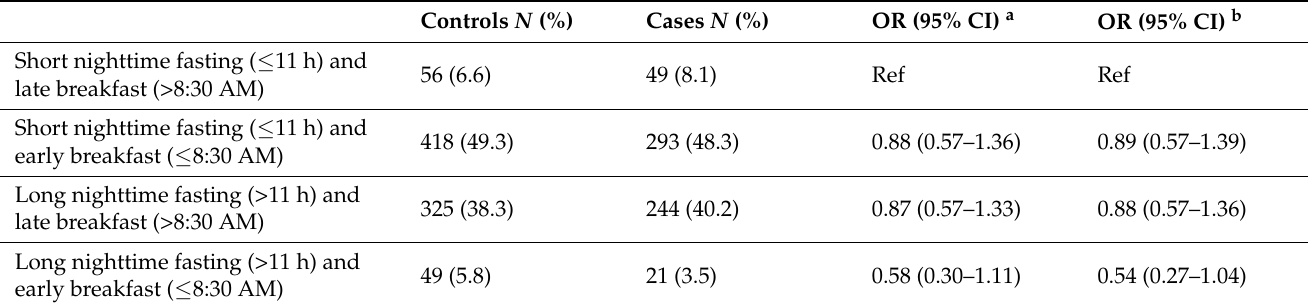
Table 5. Association of nighttime fasting and time of breakfast with prostate cancer